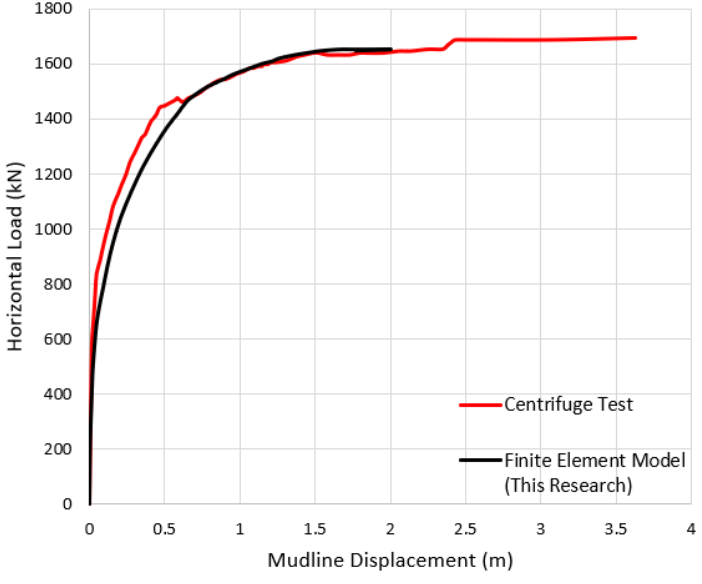
Figure 11. Validation of the monotonic